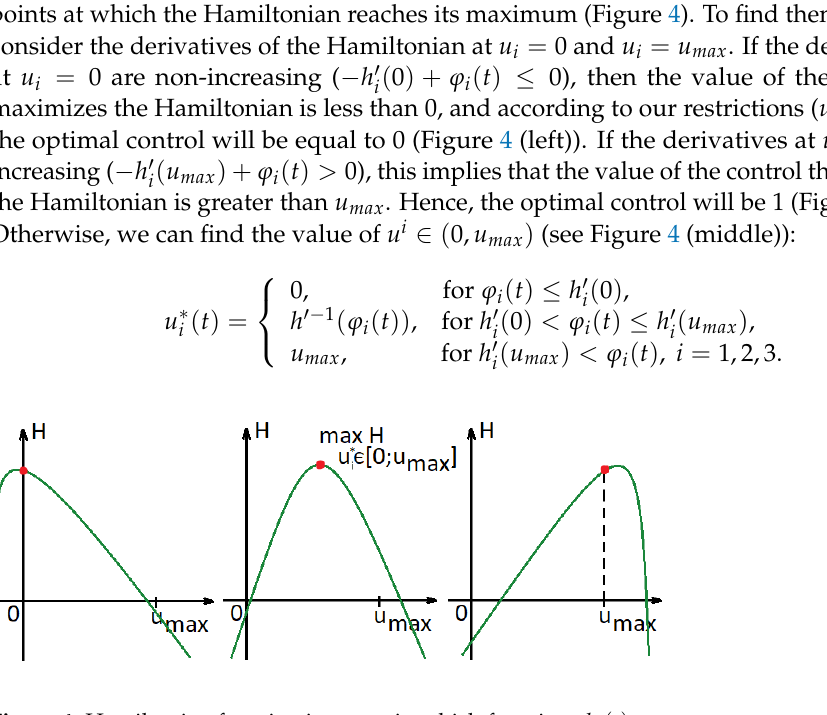
Figure 4. Hamiltonian function in a case in which functions h i ( · ) are